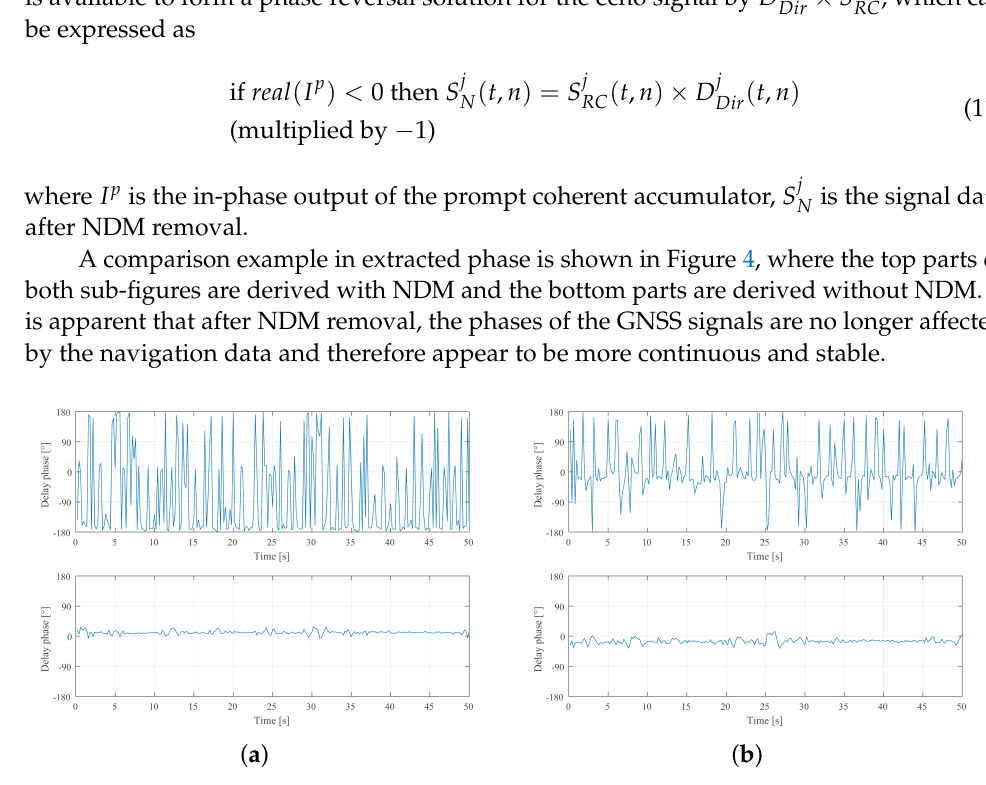
Figure 4. Comparison example in extracted phase ( a ) GEO C01 observation (top) with NDM and (bottom) without NDM; ( b ) GEO C04 observation (top) with NDM and (bottom) without